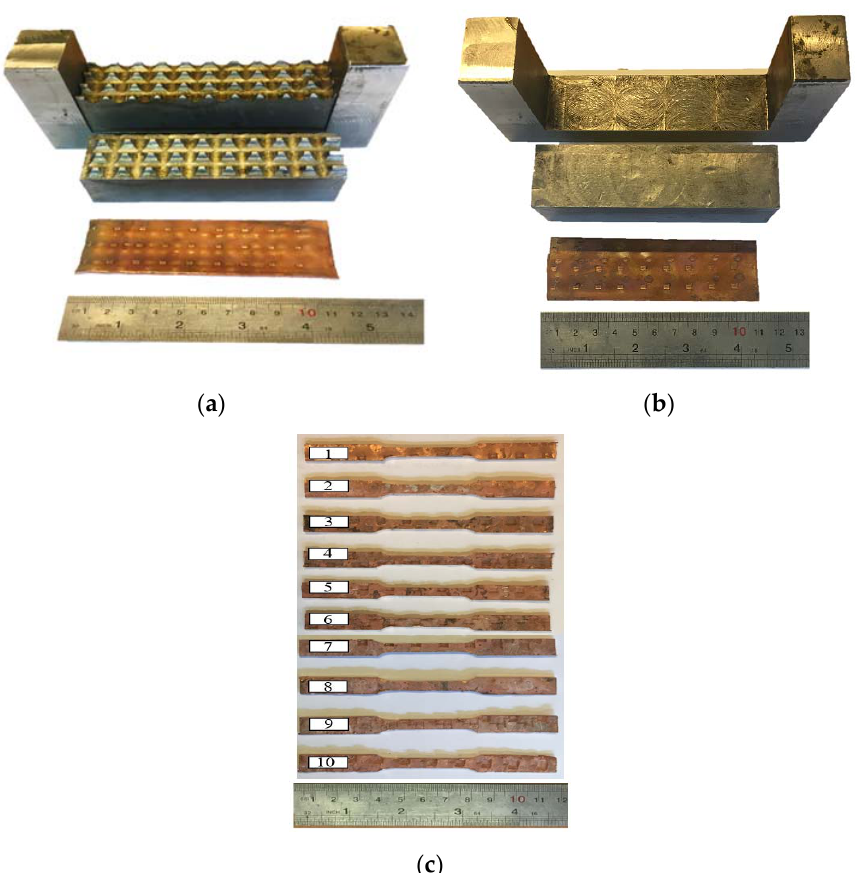
Figure 3. ( a ) The curved studded corrugation dies and corrugated sheet, ( b ) the flattening dies and straightened sheet in the modified ‐ CSP method, ( c ) uniaxial tensile test specimens for the first to tenth passes of the modified ‐ CSP.